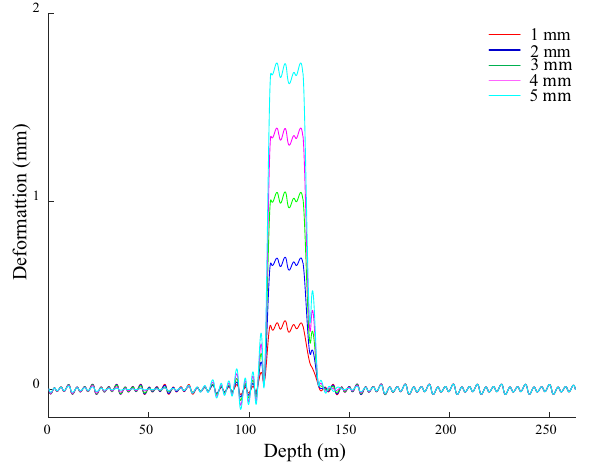
Figure 17. GRD in x -direction under horizontal section